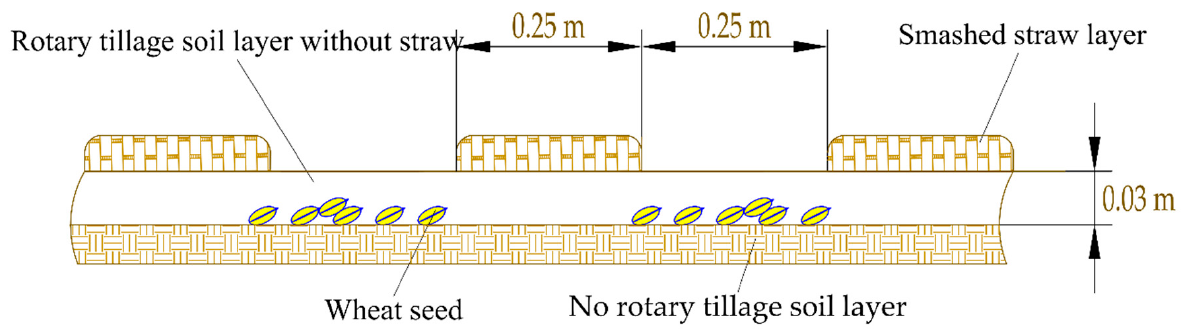
Figure 1. Sowing mode of wheat with wide planting belt in a rice straw mulching field.